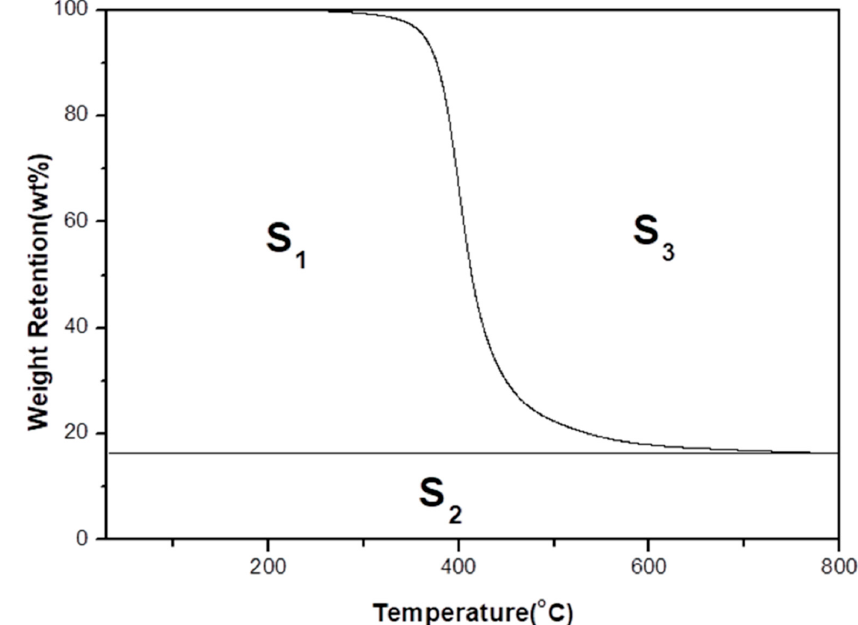
Figure 6. TGA curve for the composite.